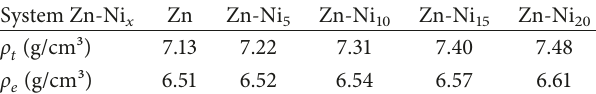
Table 1: Comparison of the theoretical and experimental densities of Zn-Ni x metal compounds.